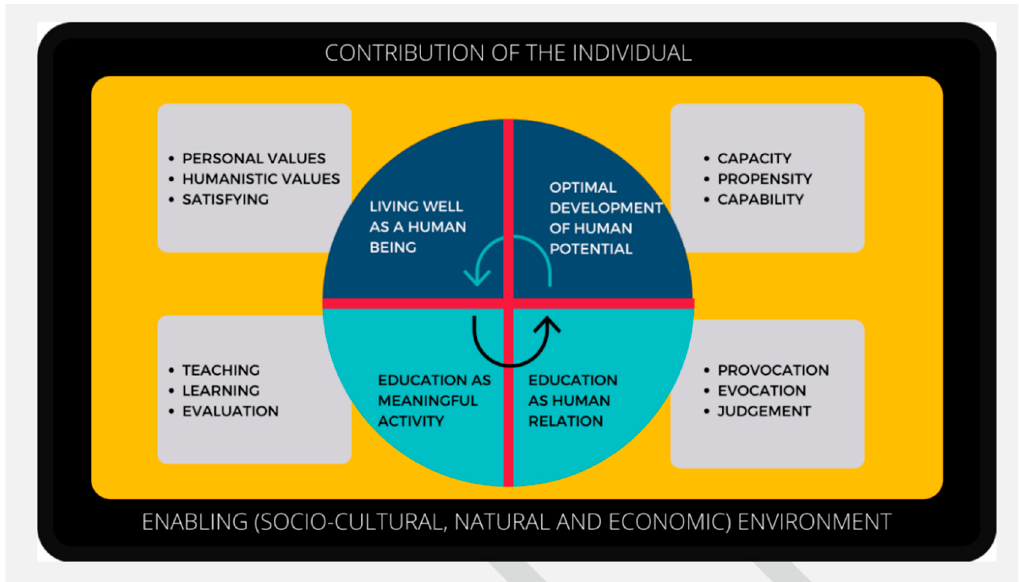
Figure 7. A visual representation of the relationship between flourishing and education, UNESCO ISEE Report, 2021.